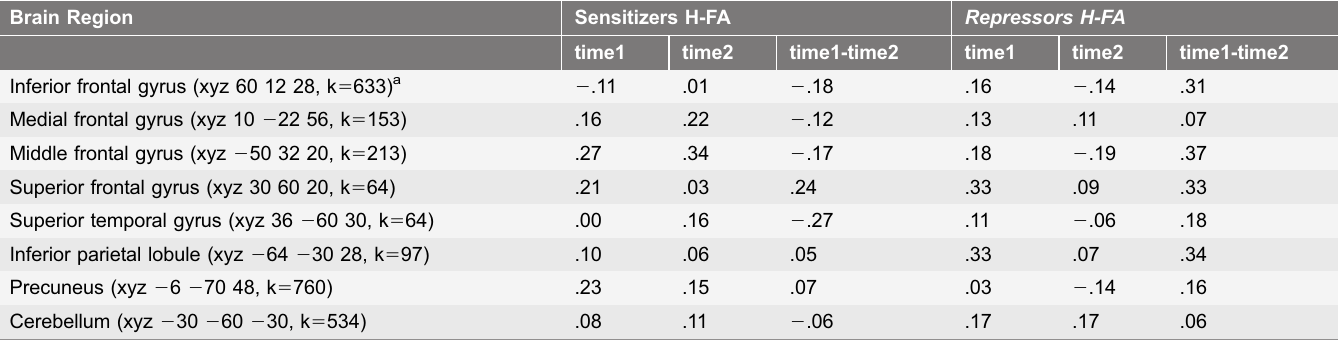
signals a potential impending attack (of the person opposite the observer). Fear faces are not signalling direct threat to the observer but indicate the existence of a threatening event or stimulus in the environment [38]. Therefore, fearful faces can be interpreted as signals requiring clarification regarding the spatial source of a potential danger and therefore seem not directly threatening. Our evaluation data are also in line with this interpretation because fearful faces were rated as less threatening than angry faces (see table 2). According to the repressive Table 7. Correlations between mean cluster activation in regions with heightened response to angry faces (in repressors compared to sensitizers (see Table 5)) and discrimination performance H-FA for angry faces at time 1 and time 2 and loss of discrimination accuracy for angry faces from time 1 to time 2 (H-FA time1 minus H-FA time2) as a function of coping